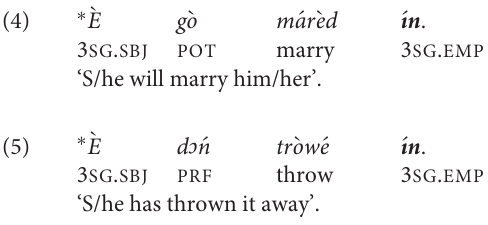
An example of case assignment in 1 SG pronouns (object vs.